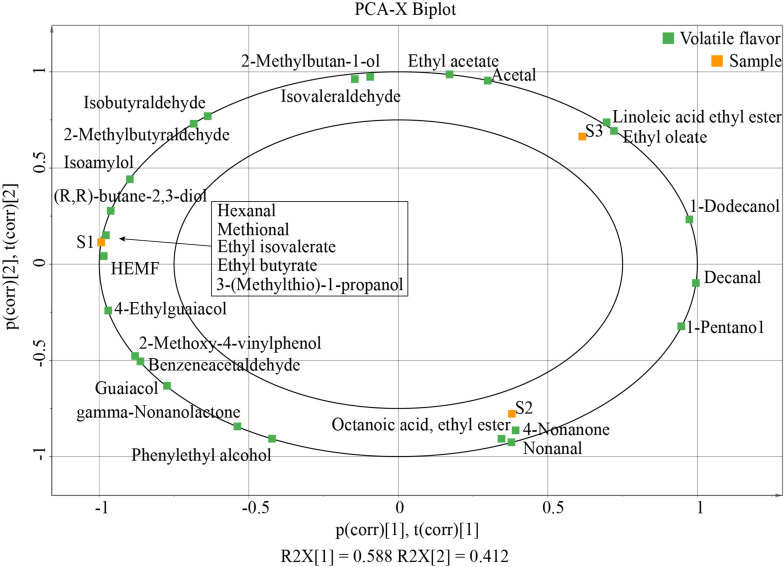
Score plot of principal components 1 and 2 for aroma compounds by PCA.